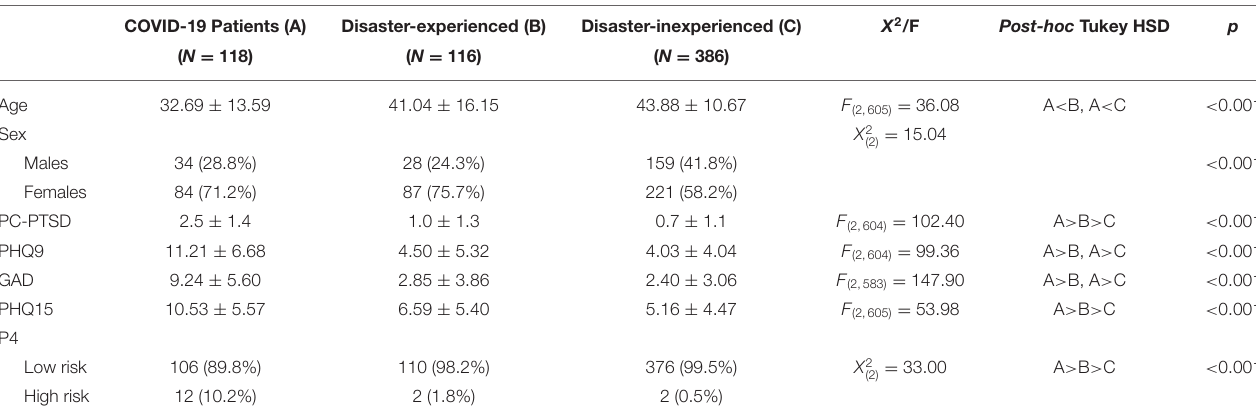
TABLE 1 | Demographic and clinical characteristics of the participants. COVID-19 Patients